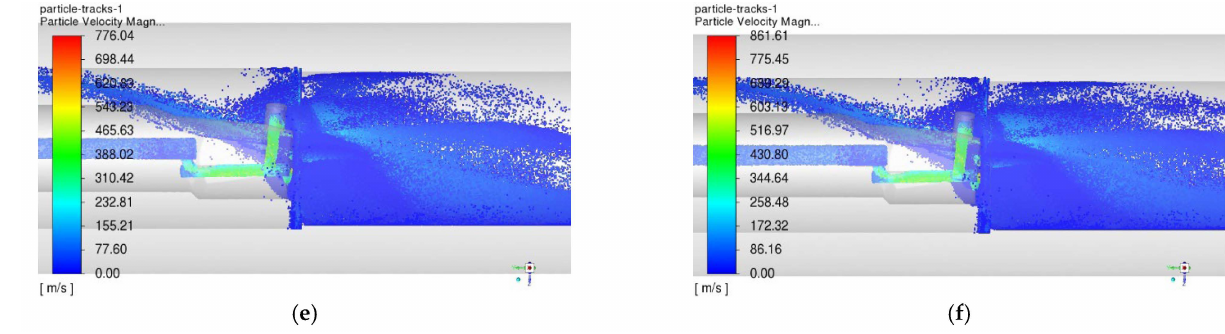
Figure 8. Droplets velocity under different inlet pressures, ( a ) 0.1 MPa, ( b ) 0.2 MPa, ( c ) 0.3 MPa, ( d ) 0.4 MPa, ( e ) 0.5 MPa, ( f ) 0.6 MPa.